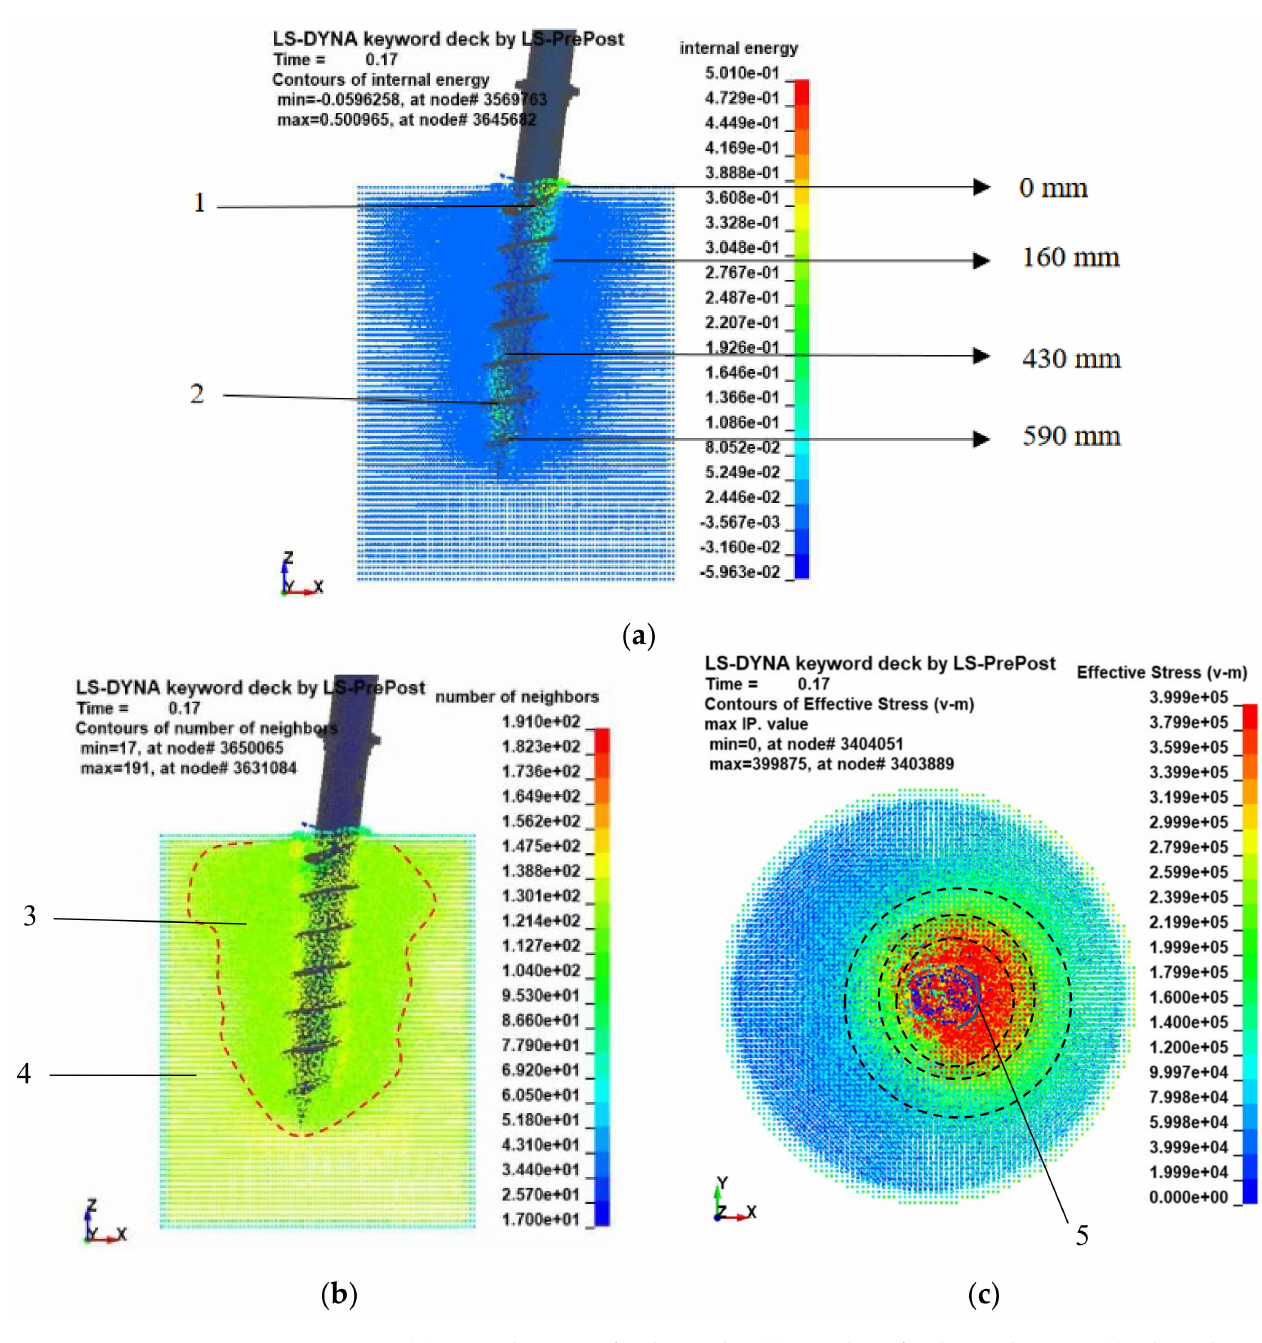
Figure 7. ( a ) Internal energy of soil particles; ( b ) Number of soil particle zones; ( c ) pile–soil interac- tion